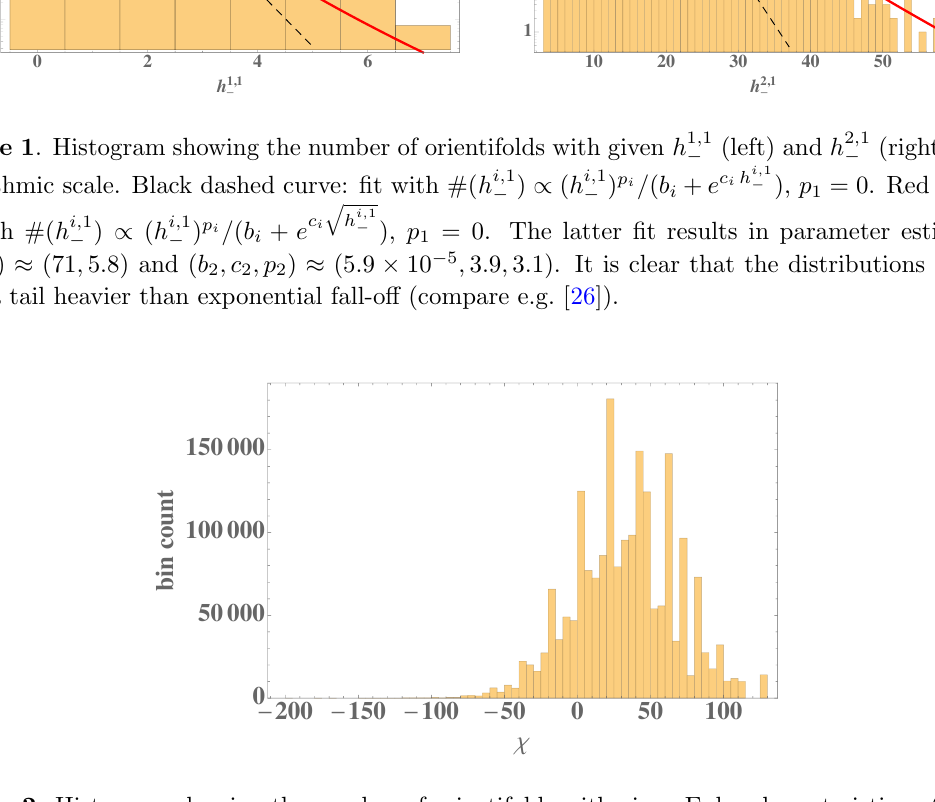
Figure 2 . Histogram showing the number of orientifolds with given Euler characteristic (cid:31) (of the CY threefold) with bin width 5. The most negative value occurs for the quintic with (cid:31) = (cid:0) 200. Given that (cid:31) ’s of both signs appear it is tempting to speculate that our list of CYs contains pairs related by mirror symmetry. The mean is shifted to positive values, because we reach smooth CYs by going through conifold transitions from the deformed to the resolved side, strictly increasing (cid:31)